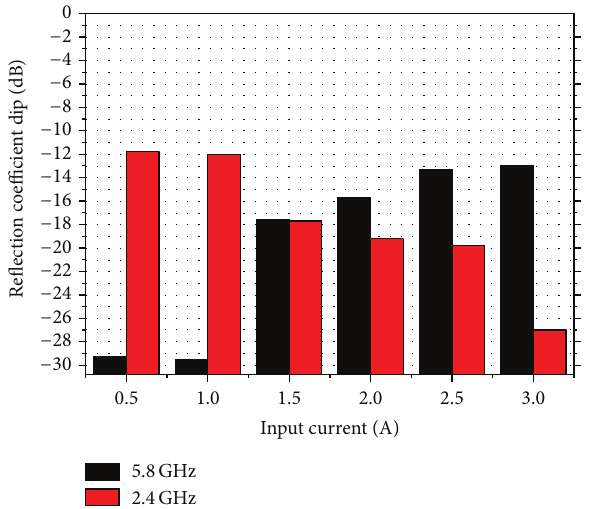
Figure 5: Measurement of reflection coefficient dips as a function of laser